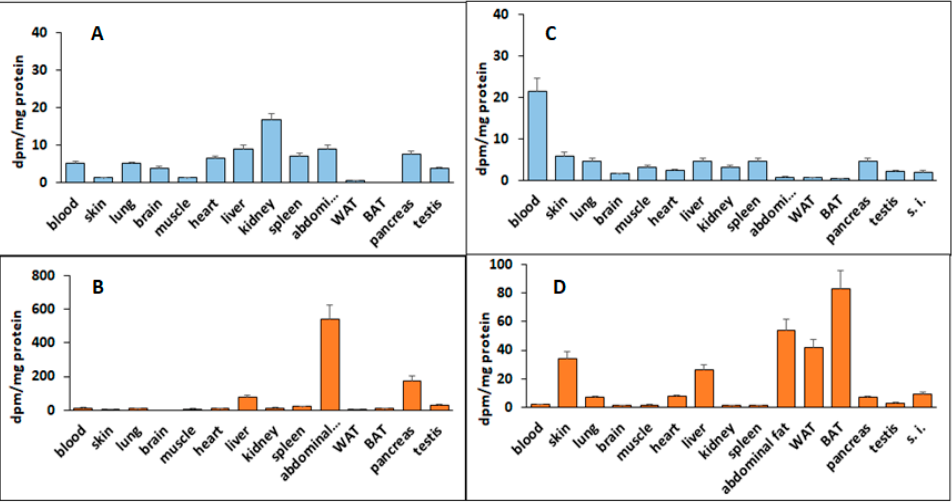
Figure 4. Deh-T3 β metabolism and metabolite distribution in different organs of db/db mice (n = 3). ( A ) Hydrophilic phase (methanol:water) 24 h after treatment by intraperitoneal injection; ( B ) hydrophobic phase (chloroform) 24 h after intraperitoneal injection of deh-T3 β ; ( C ) hydrophilic phase after 10 days of deh-T3 β treatment by diet; ( D ) hydrophobic phase after 10 days’ deh-T3 β treatment by diet. Results are means ± SD of three independent experiments.